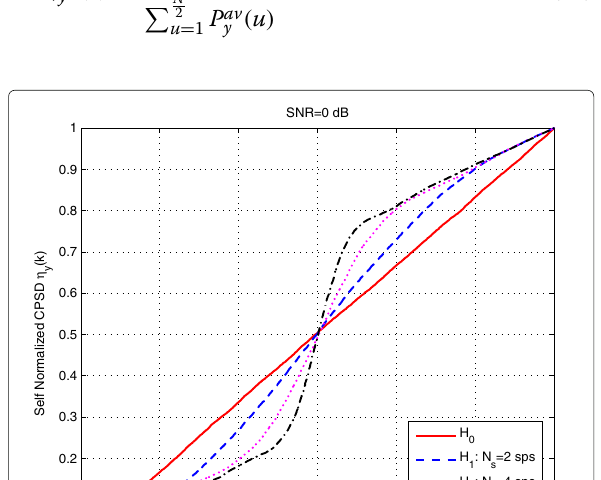
Fig. 11 Self-normalized CPSD under H 0 and H